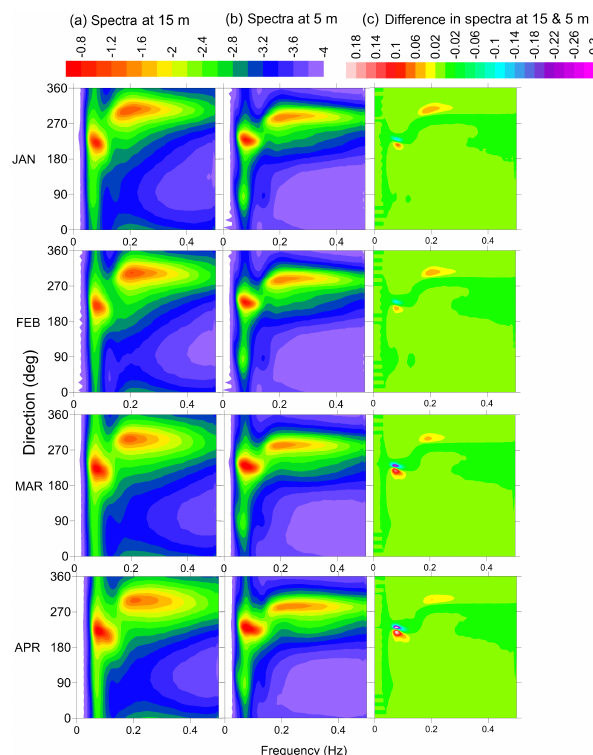
Figure 10. (a) Monthly average directional spectra at 15m water depth and (b) at 5m water depth. The contours are spectral energy density (m 2 Hz − 1 ) in log scale. Plot (c) is the difference in spectral energy at 15 and 5m water depth in m 2 Hz − 1 degree − 1 .